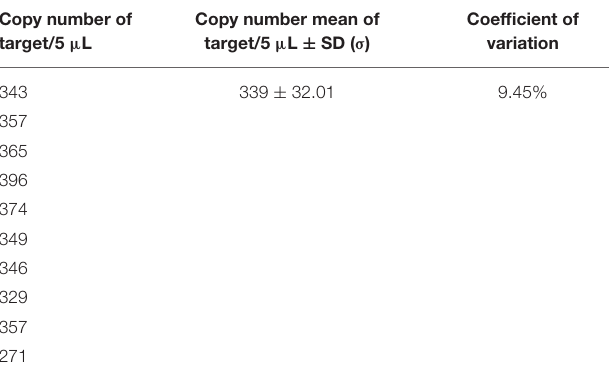
TABLE 4 | Copy numbers obtained on dilution of genomic DNA at ∼ 500 copies/5 µ L by digital PCR on a Biomark TM HD